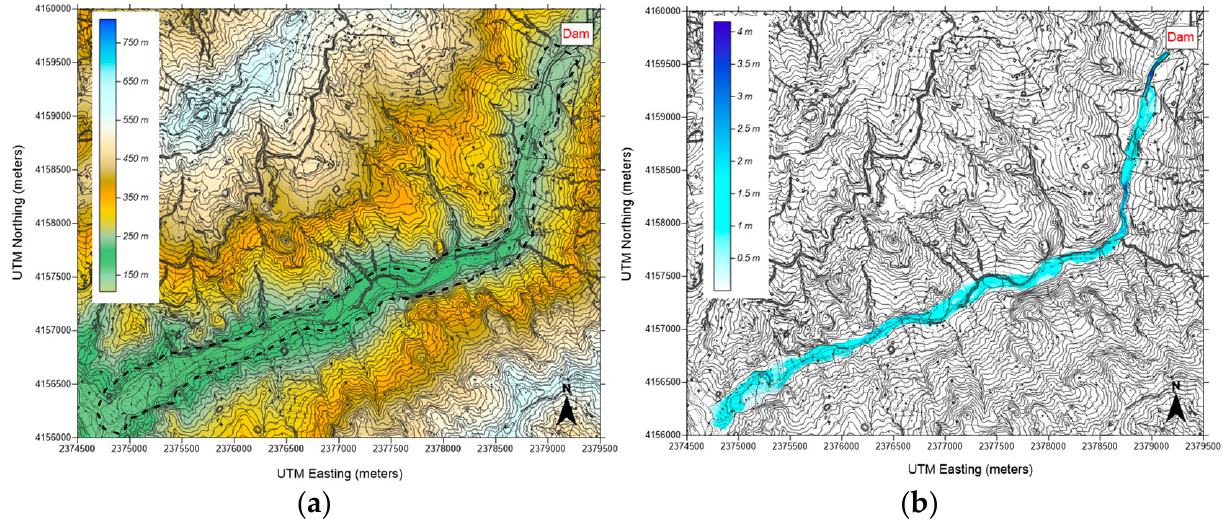
Figure 13. MLFP-2D model implementation: ( a ) layout of the model domain, including 2-m resolu- tion DTM and the domain boundary (black dotted line); ( b ) inundated area for a single random generated hydrograph and a given initial water level reservoir condition (IWL1).